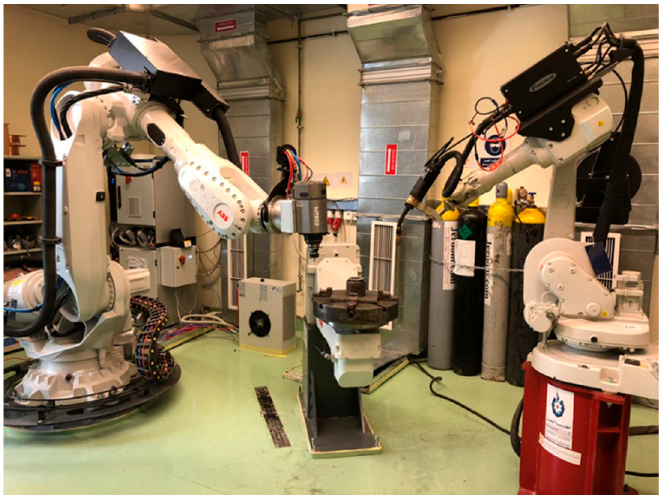
Figure 1. A picture for the additive/subtractive robotic-controlled manufacturing system, AMCL, the American University in Cairo.